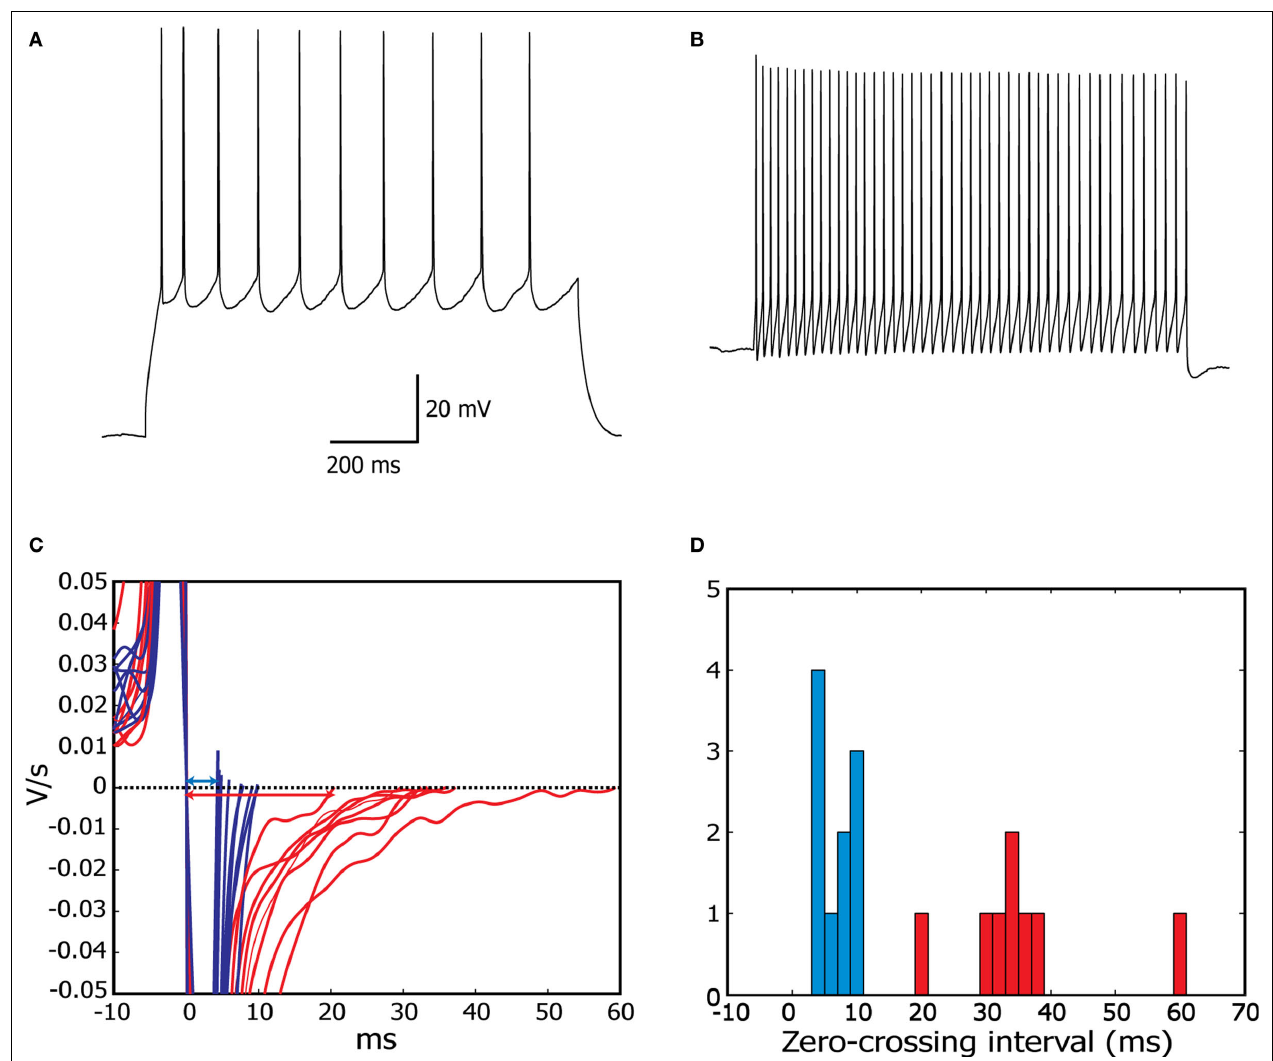
FIGURE 2 | Assignment of neurons to fast-spiking or regular-spiking electrophysiological phenotypes in cortical slices. (A,B) Regular-spiking (A) and fast-spiking cells (B) , responding to step current stimulation. (C) Smoothed derivative of the action potential signals for all cells, centered on the fi rst downward zero-crossing, corresponding to the peak of the AP. This clearly